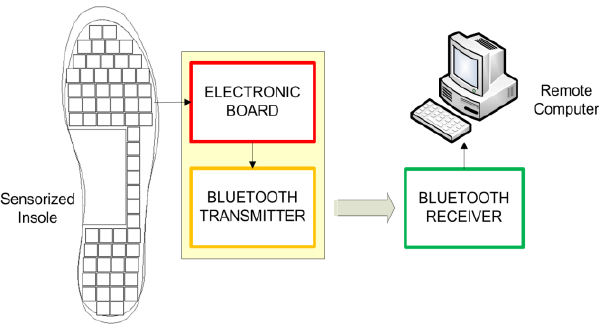
Figure 1. Overview of the system